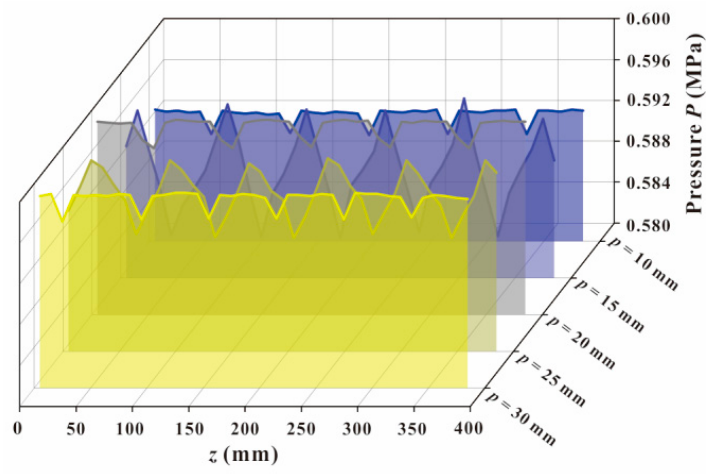
Figure 12. Pressure distribution with a fin height h = 10 mm and fin thickness t = 2 mm.